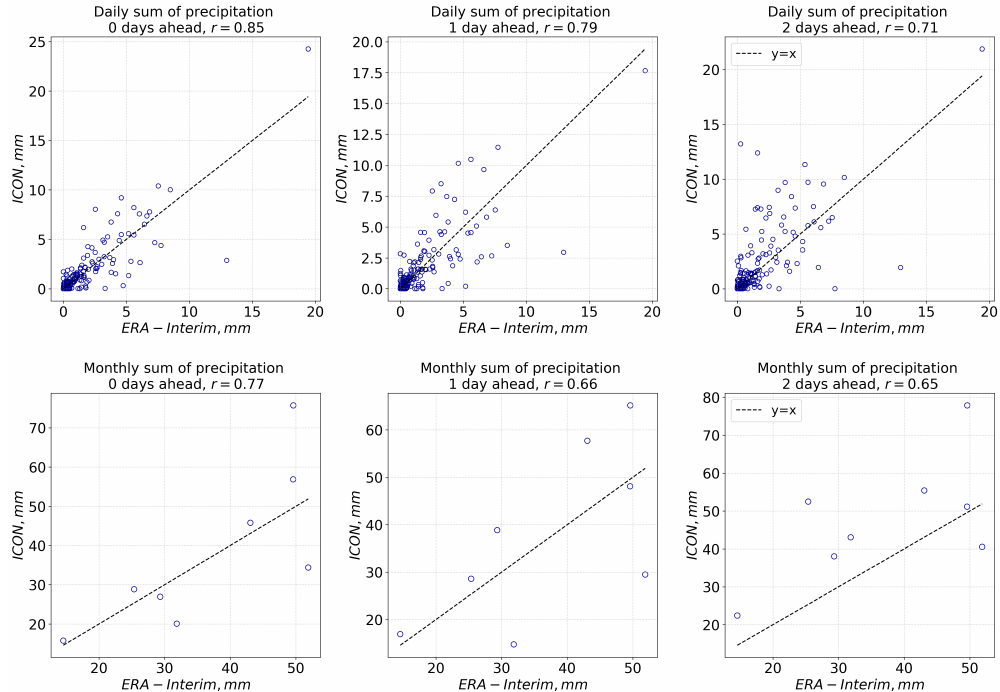
Figure 7. Relationship between daily ( top row ) and monthly ( bottom row ) precipitation estimates provided by ERA-Interim and ICON data for Moskva R. at